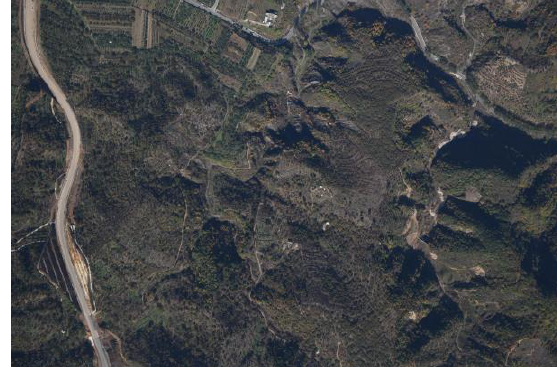
Figure 9. An UAV image from images acquired in 2016